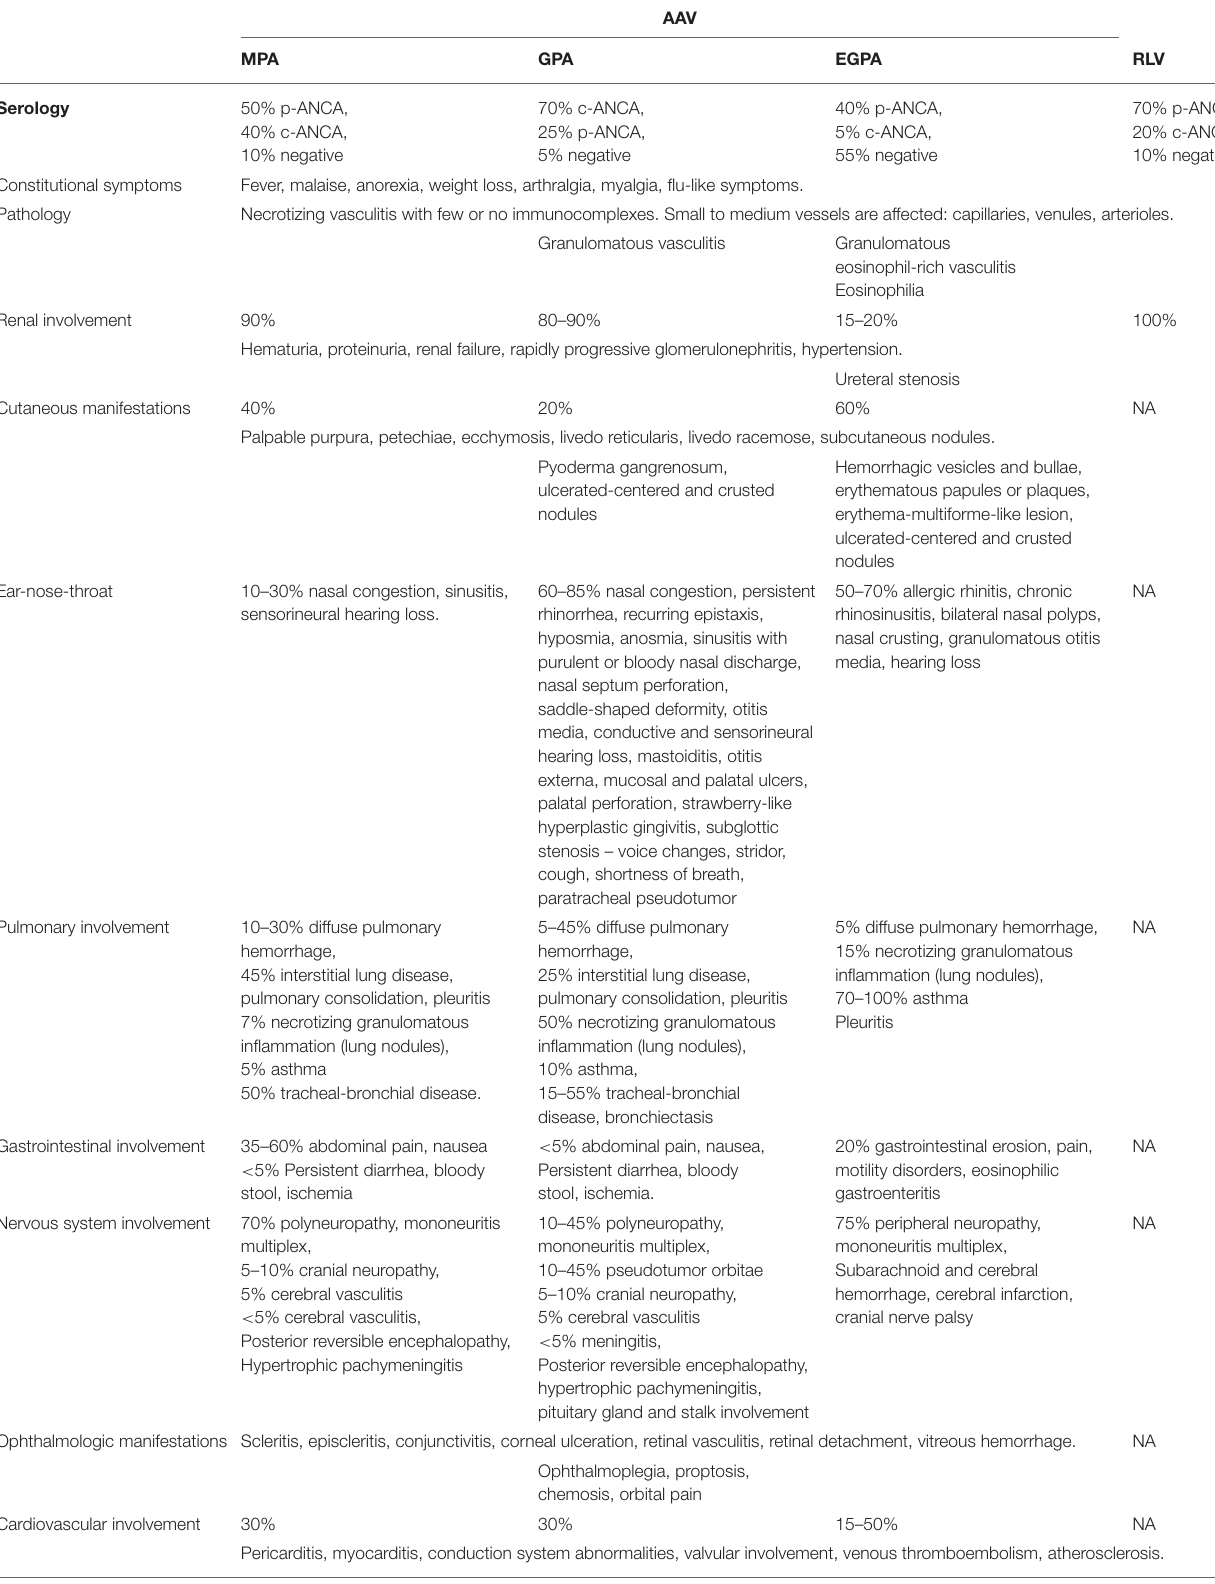
TABLE 1 | Renal and the most common extra-renal symptoms of ANCA-associated